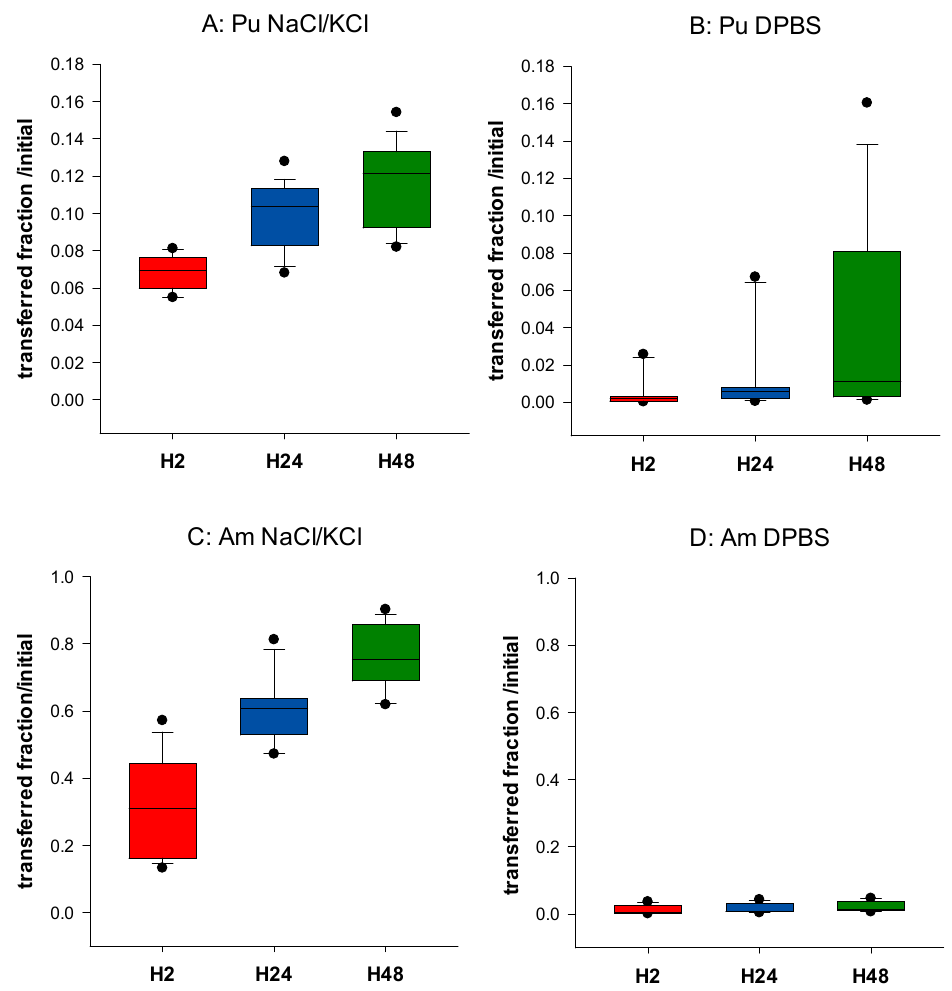
Figure 1. Influence of phosphate on Pu and Am transfer. Pu ( A , B ) or Am ( C , D ) were included in the static retention phase (agarose gels) prepared in NaCl/KCl ( A , C ) or in DPBS ( B , D ). After 2, 24, and 48 h incubation in NaCl/KCl or DPBS, the transferred activity was measured in the dynamic phase using liquid scintillation counting. Results are expressed as cumulative activity/initial activity in the gel. Each experimental condition was done in triplicate and repeated 6 times.